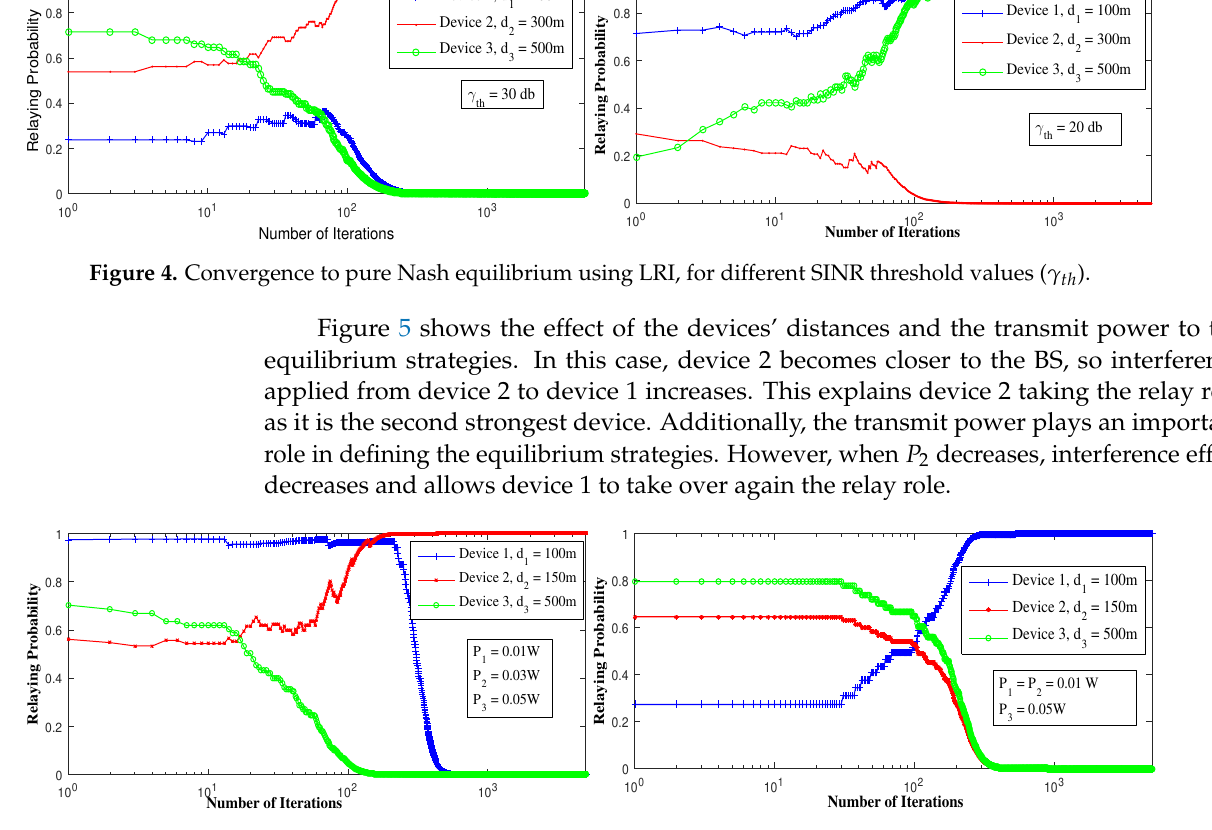
Figure 5. Convergence to pure Nash equilibrium using LRI, for different transmit powers of device 2. In Figure 6, we see that device 3 decides to serve as a relay when its distance from the BS decreases. By doing so, interference applied from device 3 to device 2 increases, which decreases γ 2 that is why device 3 serves as a relay. Note that device 3 is the weakest but at the same time it is the only device that doesn’t interfere with the other devices’ signals, once on the cellular side. It prefers, then, to serve as a relay than to be in D2D and get affected by other devices’ interference. However, minimizing the fraction of throughput device 3 gets for itself, if it serves as a relay, minimizes its throughput and ruins the equilibrium. That is why device 2 takes over the relaying mission in the second figure when x 3 decreases. For the same reason, device 1 serves as a relay when x 2 and x 3 decreases. This observation shows the importance and effectiveness of the decentralized RL algorithm to allow the devices to attain the equilibrium by converging to the pure action